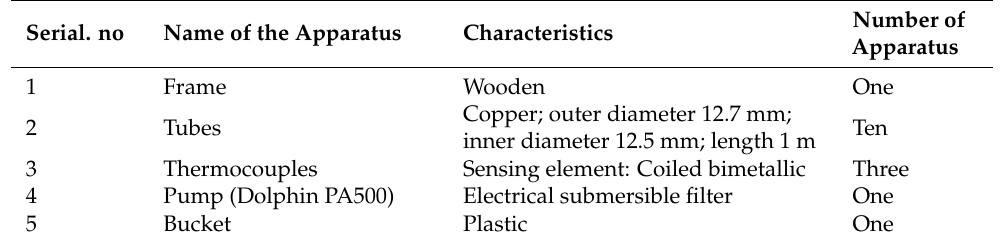
Figure 6. Arrangement of FPSC under solar radiation.